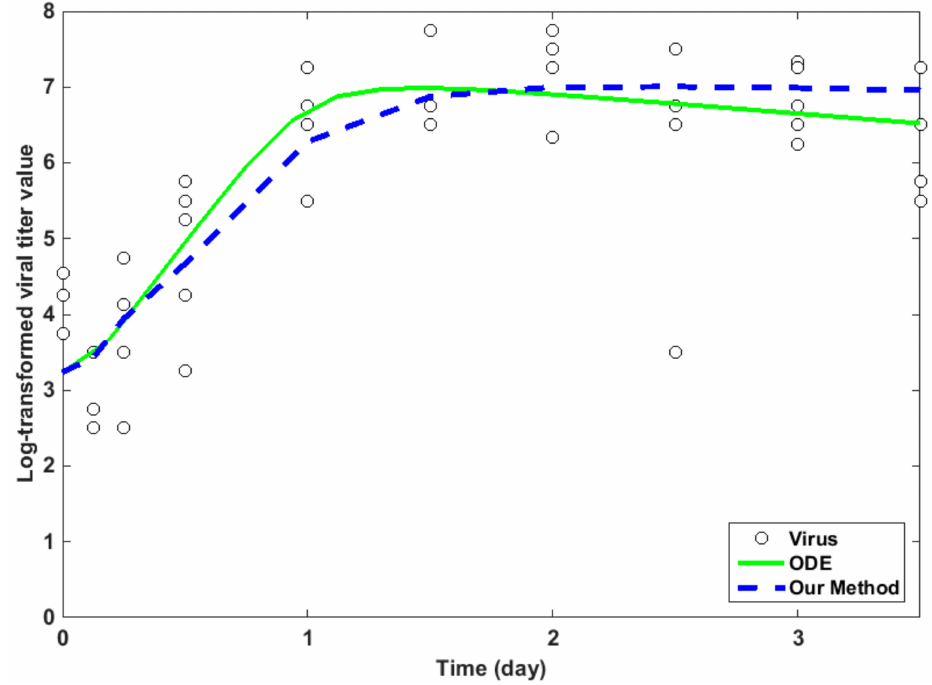
Figure 3. Fitting accuracy of the proposed method and ordinary differential equation (ODE) method